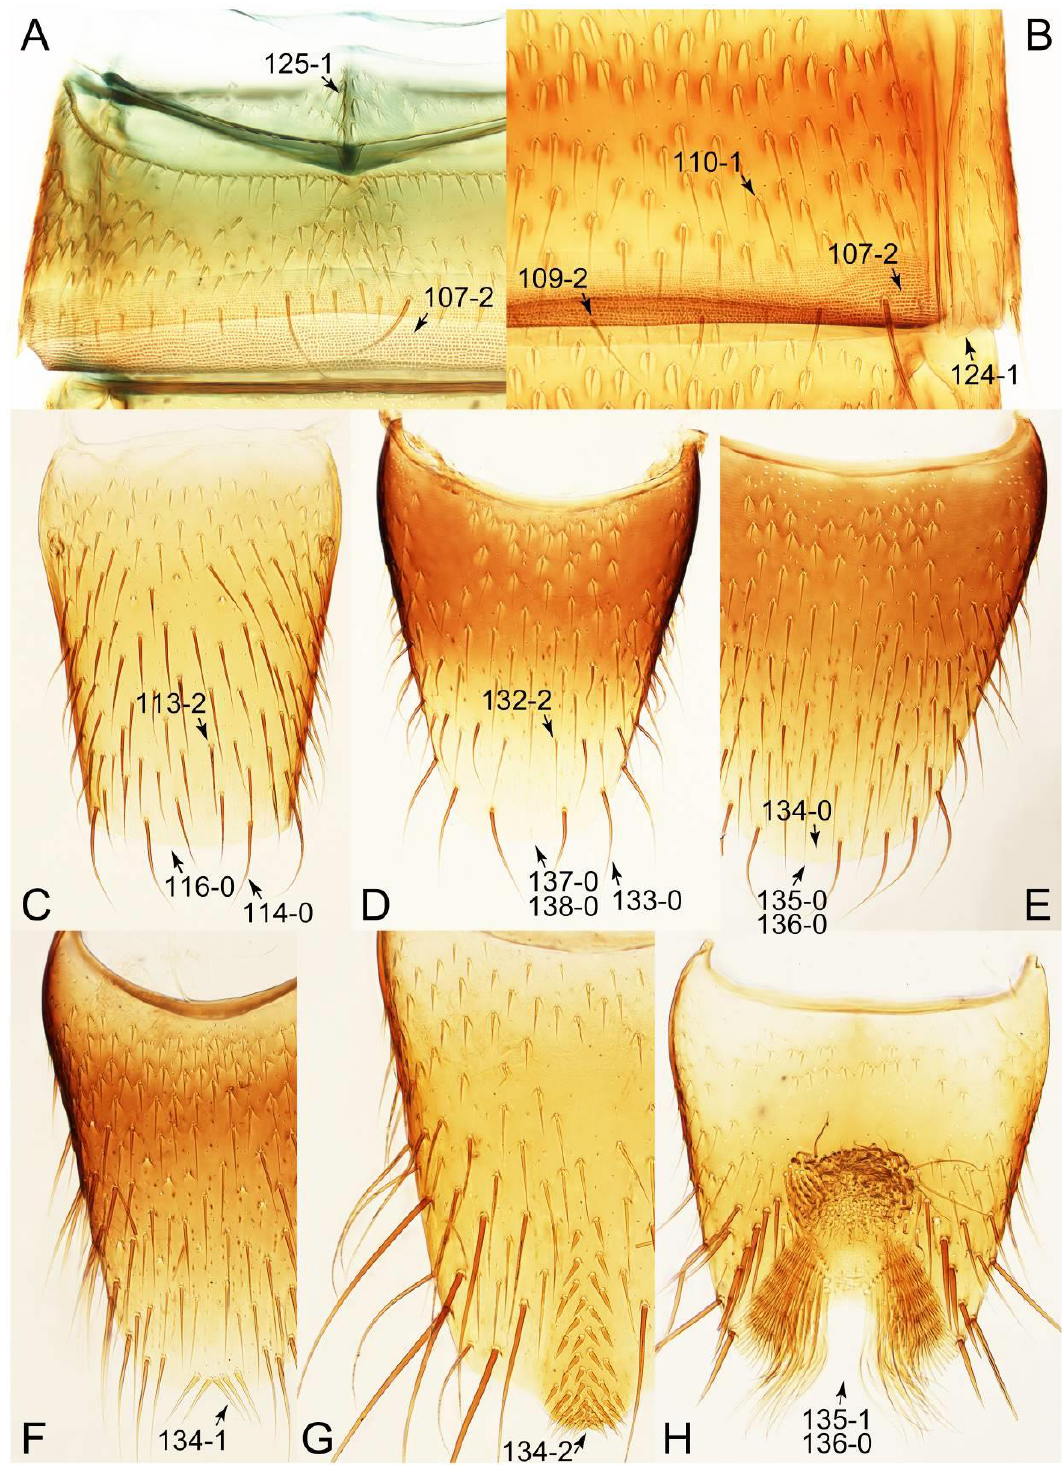
Figure 71. Photographs of body parts of Mycetoporinae, enlarged. ( A ) sternite III of Carphacis effrenatus , ventral view. ( B ) posterior margin of tergite V of Carphacis effrenatus , dorsal view. ( C ) male tergite VIII of Mycetoporus punctus , dorsal view. ( D ) female sternite VIII of Lordithon thoracicus thoracicus , ventral view. ( E ) male sternite VIII of Mycetoporus punctus , ventral view. ( F ) male sternite VIII of Bryoporus cf. orientalis , ventral view. ( G ) male sternite VIII of Bolitobius castaneus , ventral view. ( H ) male sternite VIII of Ischnosoma splendidum , ventral view. Characters and character states (format X-X) are indicated on each